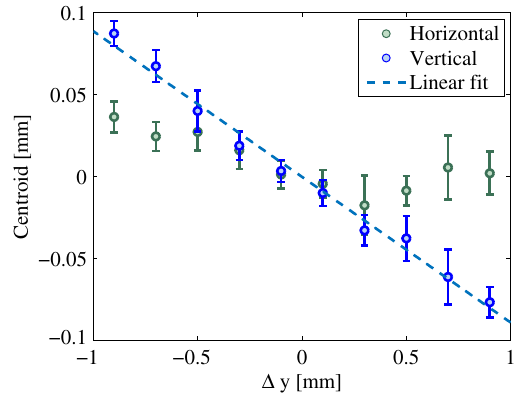
FIG. 23. Measured vertical position of the centroid of the electron beam passing the 3 mm diameter aperture of the collimator versus the displacement of the collimator axis with respect to the bunch on a downstream YAG screen. The horizontal centroid is shown to give an idea of the machine jitter.